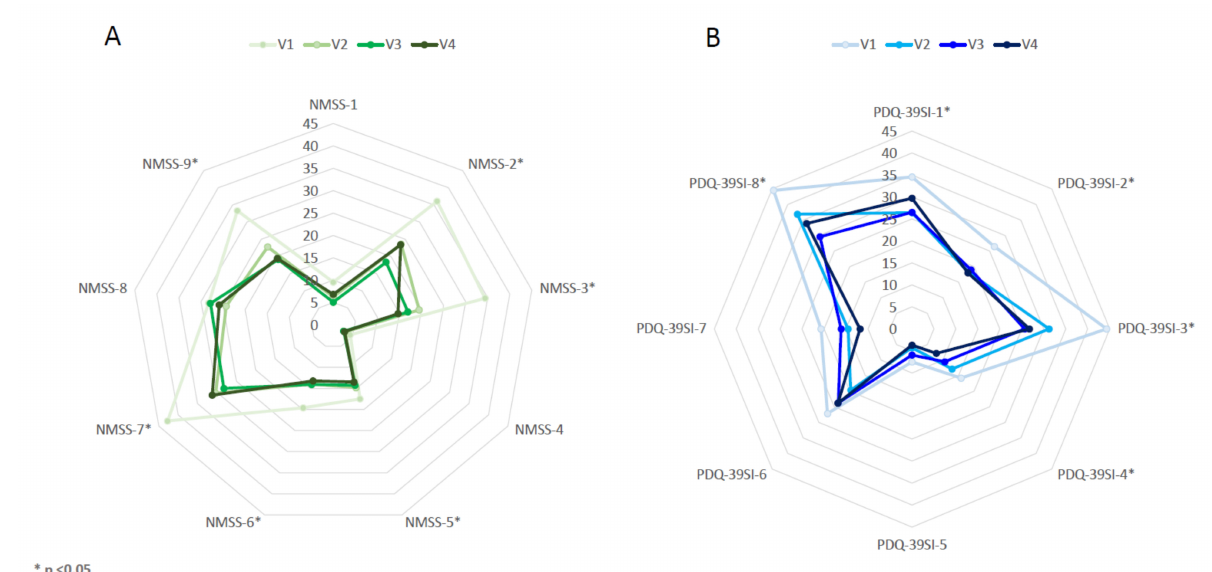
Figure 2. ( A ) Mean score on each domain of the NMSS scale at V1 (baseline), V2 (1 months ± 7 days), V3 (3 months ± 15 days) and V4 (6 months ± 15 days). The difference between V1 and V4 was significant for NMSS-2 (Sleep/fatigue) ( p = 0.003), NMSS-3 (Depression/apathy) ( p < 0.0001), NMSS-5 (Attention/memory) ( p = 0.026), NMSS-6 (Gastrointestinal symptoms) ( p = 0.010), NMSS-7 (Urinary symptoms) ( p = 0.003) and NMSS-9 (Miscellaneous) ( p < 0.0001). ( B ) Mean score on each domain of the PDQ-39SI at V1, V2, V3 and V4. The difference between V1 and V4 was significant for PDQ-39SI-1 (Mobility) ( p = 0.037), PDQ-39SI-2, (Activities of daily living) ( p = 0.014), PDQ-39SI-3 (Emotional well-being) ( p < 0.0001), PDQ-39SI-4 (Stigmatization) ( p = 0.021) and PDQ-39SI-8 (Pain and discomfort) ( p = 0.018). p values were computed using the Wilcoxon signed-rank test. NMSs, Non-motor symptoms; PD, Parkinson’s disease; PDQ-39SI, 39-item Parkinson’s Disease Quality of Life Questionnaire Summary Index.